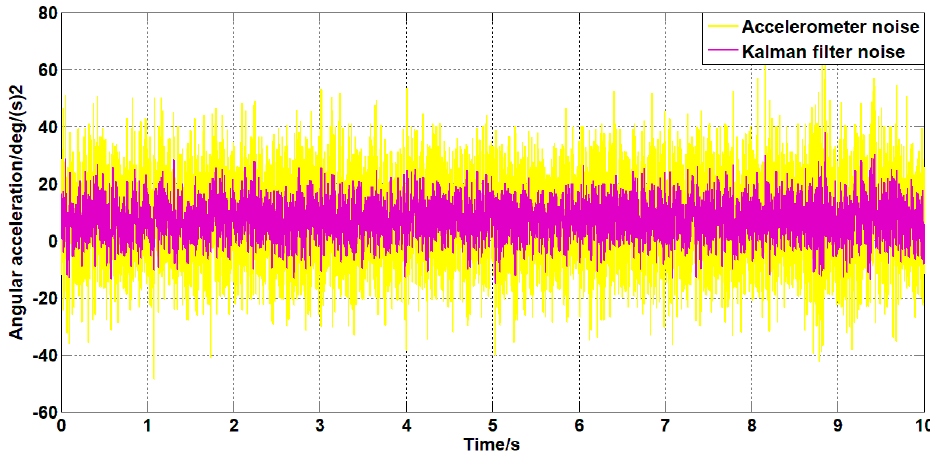
Figure 17. The angular acceleration curve after filtering by the Kalman algorithm.